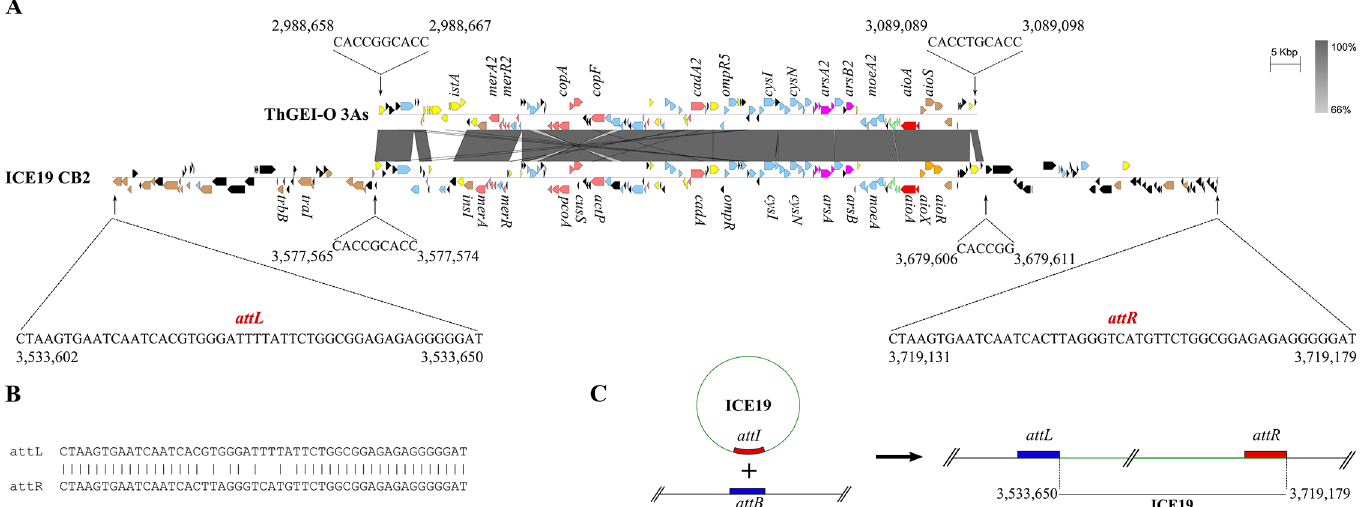
Fig 5. Schematic diagram of ICE19 in CB2. This figure shows one part of the arsenic island of CB2 (RGP19) that has the characteristics of an ICE (called ICE19) (A) Alignment of ICE19 of Thiomonas sp. CB2 with its cognate portion found in the strain 3As (ThGEI-O). The arsenic island RGP19 of CB2 is localized in a different genomic region that ThGEI-O in 3As. The ThGEI-O of 3As (upper portion of the figure) is localized in a gene encoding a 4Fe-4S ferredoxin which is intact in CB2. Direct repeat sequences are indicated. (B) Sequence comparison of the almost perfect direct repeat flanking the ICE19. attL : left DR; attR : right DR. (C) Schematic representation of the integrated and circular form of the ICE19 of CB2, which were detected by PCR. The sequence attI is identical to attR and attB identical to attL . The % of nucleotide identity is expressed along a grey scale. Figures were generated with Easyfig [50].